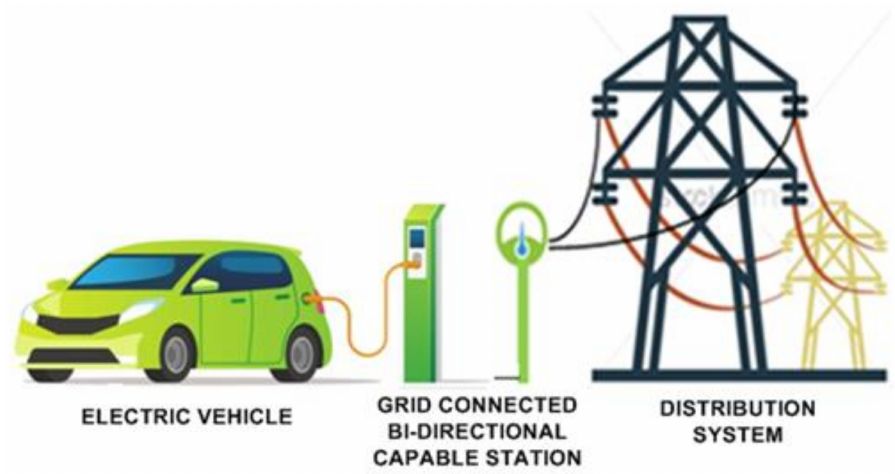
Figure 3. Electric vehicle connected to a charging